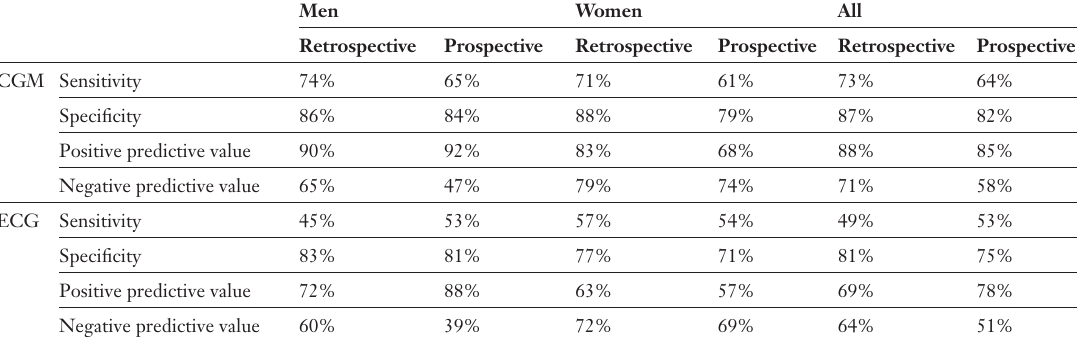
Numbers of patients according to coro- nary angiography results and cardiogo- niometry